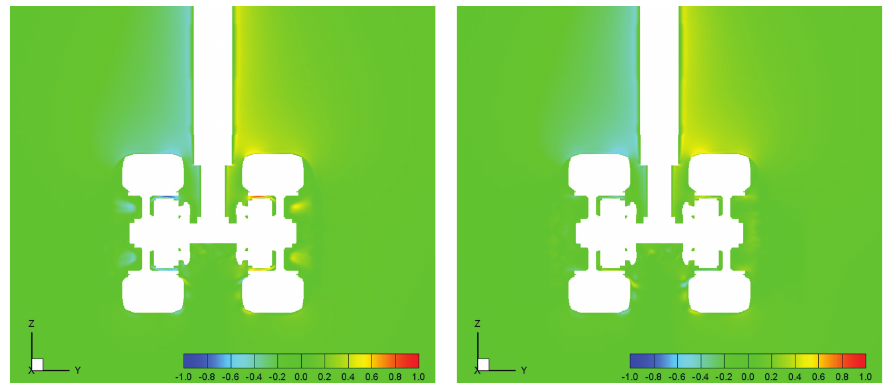
Figure 17: Computed mean velocity component in the horizontal direction at cross section x = 0 . 0 (left: BACK TEAR, right: BACK SEAL).